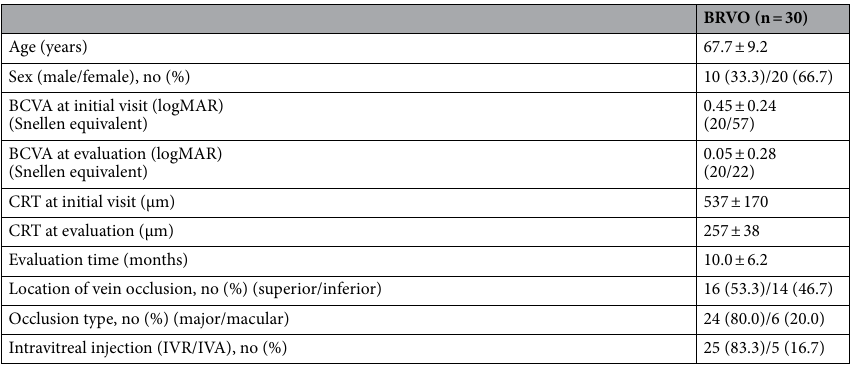
Table 1. Clinical characteristics of patients with macular oedema secondary to branch retinal vein occlusion. Values are presented as means ± standard deviation. BRVO branch retinal vein occlusion, BCVA best-corrected visual acuity, logMAR logarithm of the minimum angle of resolution, CRT central retinal thickness, IVR intravitreal ranibizumab, IVA intravitreal aflibercept injection.